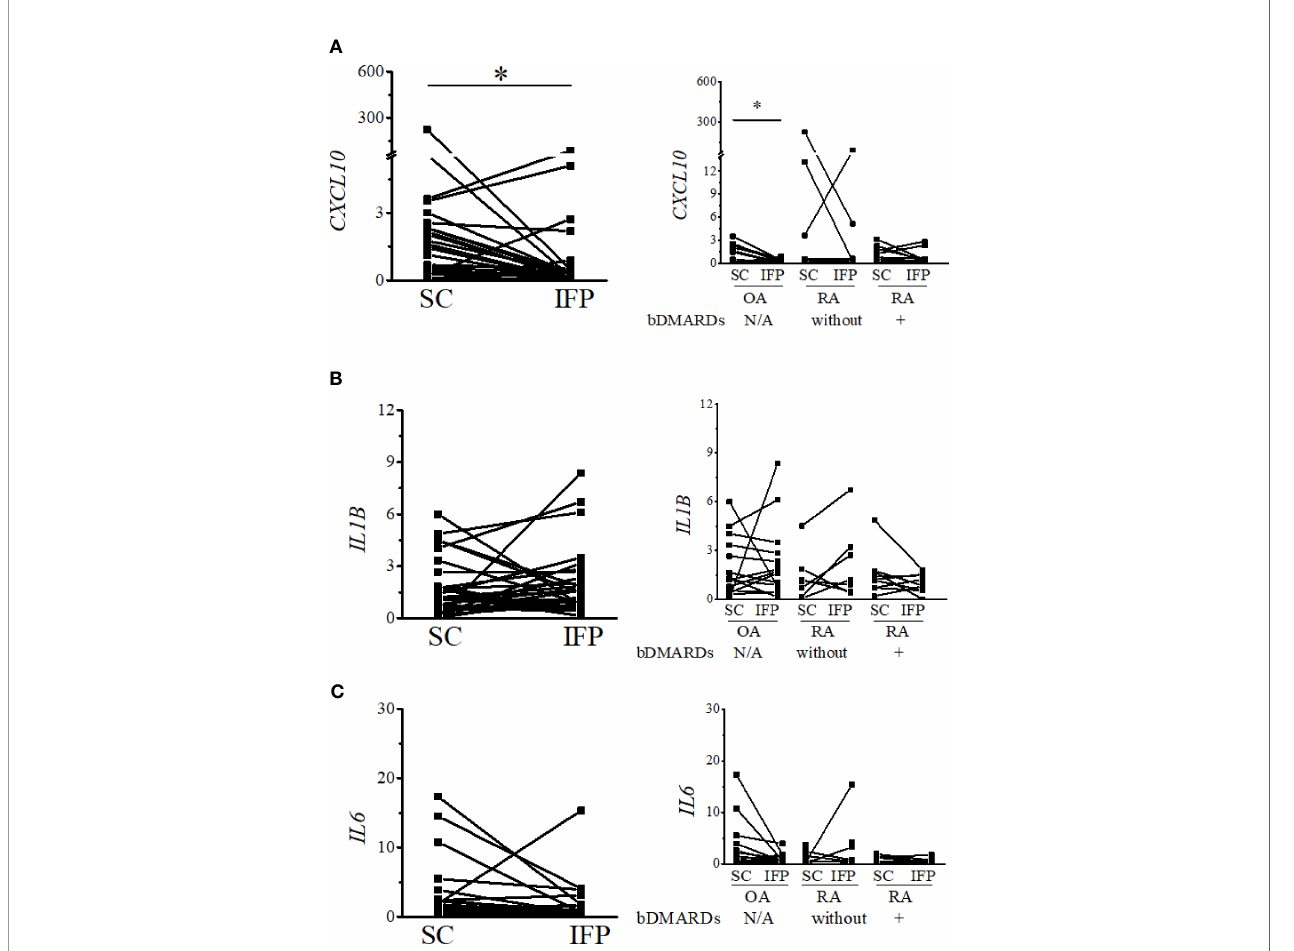
FIGURE 5 | Expression levels of in fl ammatory cytokines decrease in the IFP. Expression levels of CXCL10 (A) , IL1B (B) , and IL6 (C) in the infrapatellar fat pads (IFP) and subcutaneous fat tissues (SC) from osteoarthritis (OA) and rheumatoid arthritis (RA) patients. The panels to the left contain results comparing the expression levels between SC and IFP without division by diseases. The panels to the right contain results comparing the expression levels of SC and IFP in patients with OA, RA treated with bDMARDs, and RA who were not treated by bDMARDs. Lines connecting the dots from SC to IFP indicate samples from the same patients. The samples were labeled and separated into CD14-positive cells from the stromal vascular fraction of the IFP and SC of each patient. The median (interquartile range) expression levels of CXCL10 in the SC and IFP from patients were 1.13 (0.23 – 2.33) and 0.33 (0.10 – 0.55); the expression level in the SC was 0.98 (0.07 – 2.33) and changed to 0.17 (0.05 – 0.42) in the IFP of OA patients. Signi fi cant differences are displayed in each fi gure. OA, n = 15; RA without bDMARDs, n = 7; RA with bDMARDs, n = 9, respectively. The 2 − DD CT method was used to quantify the qPCR data. GAPDH was used as the reference gene. The average GAPDH Ct values from all SC samples were used to normalize the Ct values. The Y-axes indicate the relative expression levels of mRNA, which were normalized by GAPDH . * p < 0.05, as determined using the Mann – Whitney U -tests for differences between the IFP and SC groups and the paired-sample Wilcoxon signed-rank test for differences between the IFP and SC within the OA, RA without bDMARDs, and RA with bDMARDs groups. Data for the sample whose CXCL10 2 − DD CT value was 69.2-fold higher than the average were removed from the